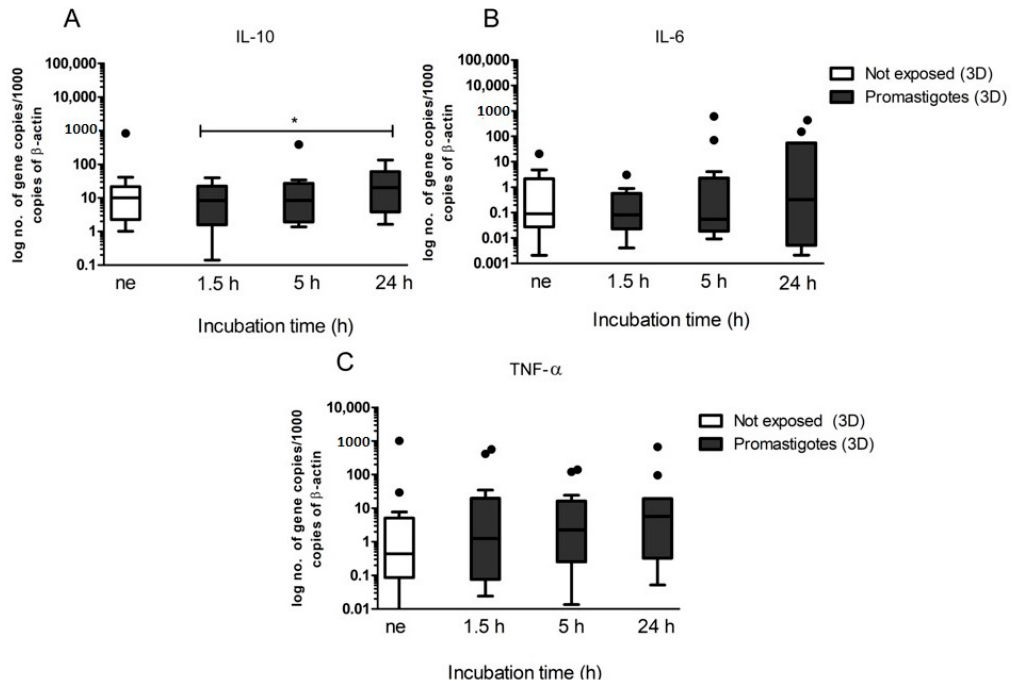
Figure 5. Gene expression of IL-10, IL-6, and TNF- α by canine hepatic spheroids exposed to L. infantum virulent promastigotes. Samples of 3D-cultured hepatocytes were used to evaluate the mRNA accumulation of IL-10 ( A ), IL-6 ( B ), and TNF- α ( C ) at 1.5, 5, and 24 h of exposure to promastigotes. In parallel, aggregates not-exposed (ne) to parasites also were evaluated. Results of 10 dogs performed in triplicate are represented by Tukey graphs. Black dots are indicative of outlier values. The non-parametric Wilcoxon test was used for statistical comparisons, and * indicates statistically significant values ( p < 0.05).